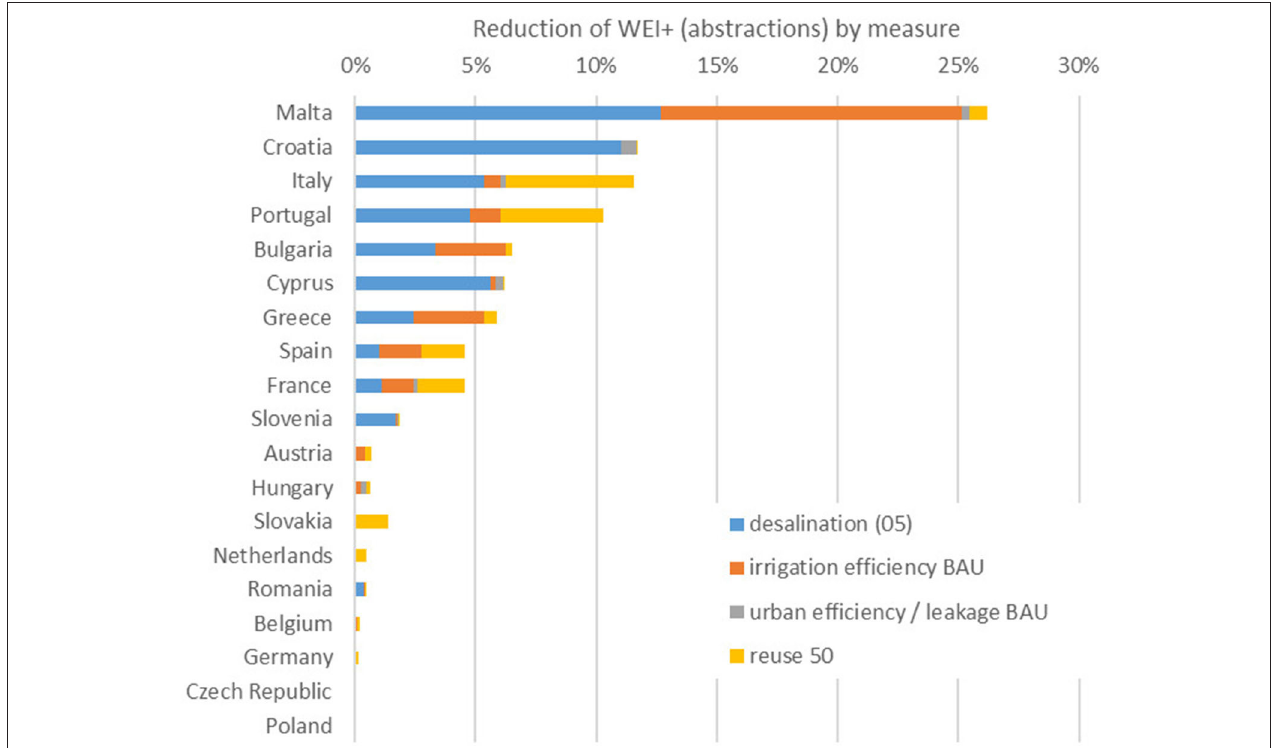
FIGURE 8 | Effects of four water efficiency measures on WEI-abstraction, as estimated with the LISFLOOD